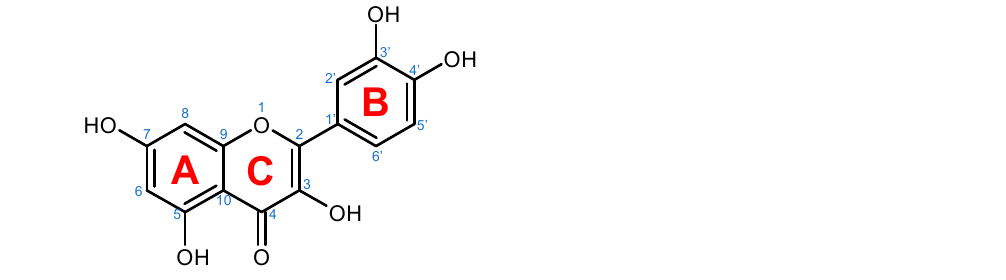
Figure 1. Chemical structure of quercetin with numbered carbon atoms (blue) and marked rings (red) on the general flavonoid backbone structure. Table 1. Dietary sources with quercetin concentrations higher than 10 mg/100 g fresh weight according to the United States Department of Agriculture Database for the Flavonoid Content of Selected Foods.